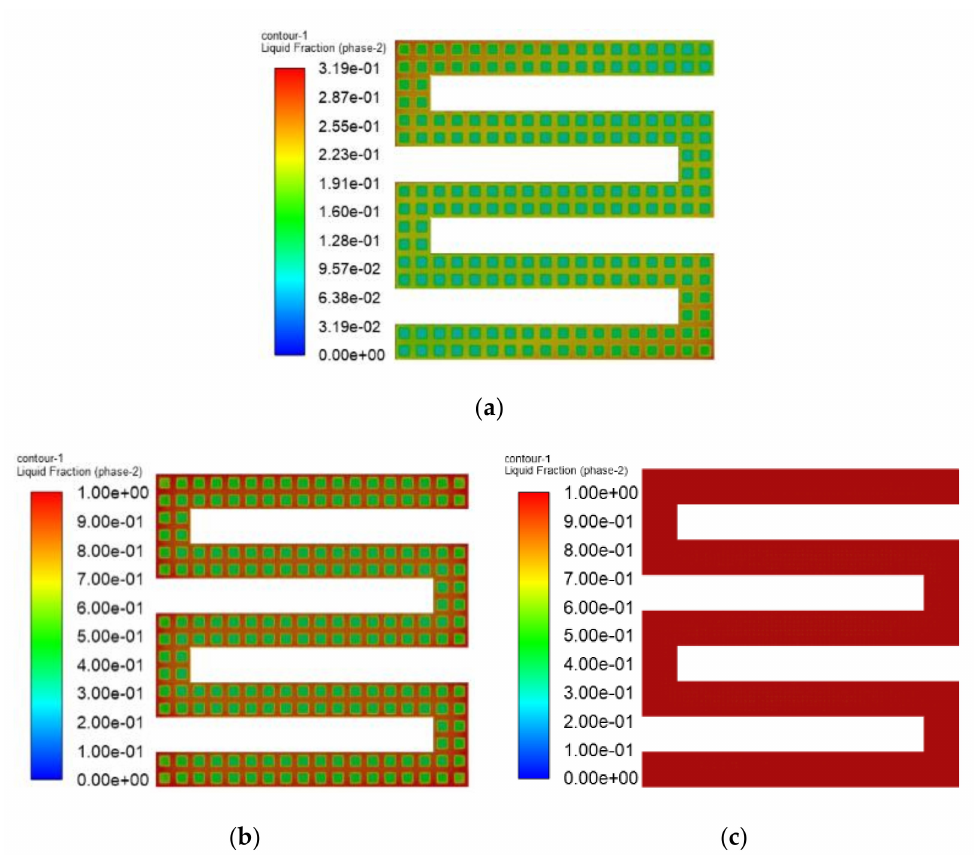
Figure 29. The fuel cell temperature contours with pore diameter = 1.2 mm at di ff erent times; ( a ) t = 32 s, ( b ) t = 42 s, ( c ) t = 48